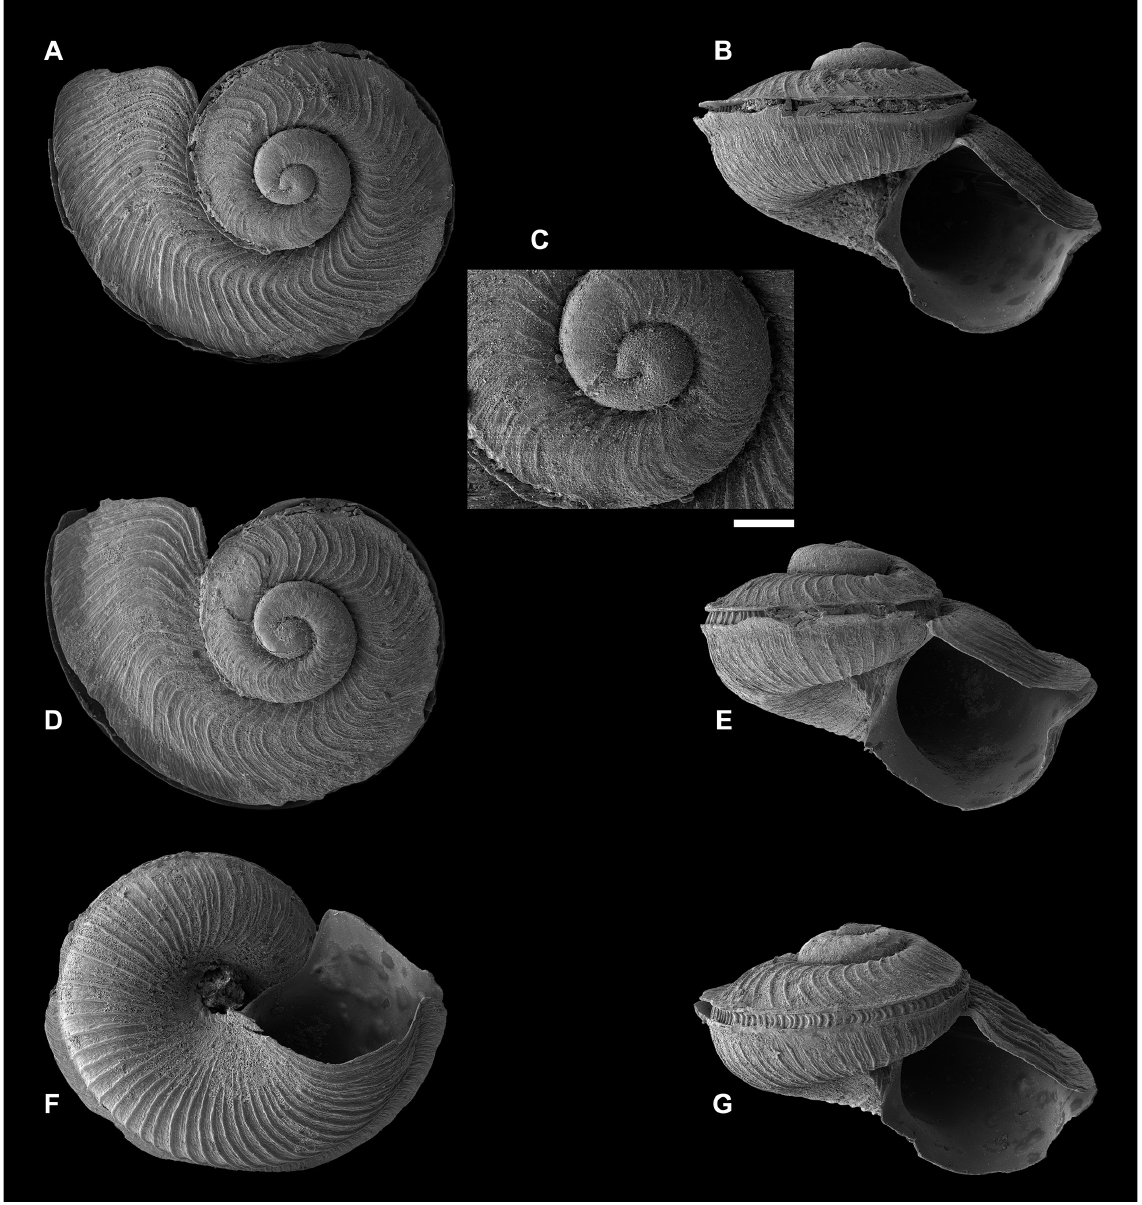
Fig. 8. Anatoma laevapex sp. nov. A, G. INDEX19_127RO. A–C . Holotype (SMF 358989) (I19_Ma_74) H 1.0 mm, W 1.5 mm, Ha 0.67 mm, Wp 0.19 mm, apical angle 119 deg. D–E . Paratype 1 (SMF 358990) (I19_Ma_75) H 0.9 mm, W 1.3 mm, Ha 0.61 mm, Dp 0.19 mm, apical angle 124 deg. F–G . Paratype 2 (SMF 358991) (I19_Ma_76) H 0.9 mm, W 1.4 mm, Ha 0.54 mm. Scale bar: 0.1